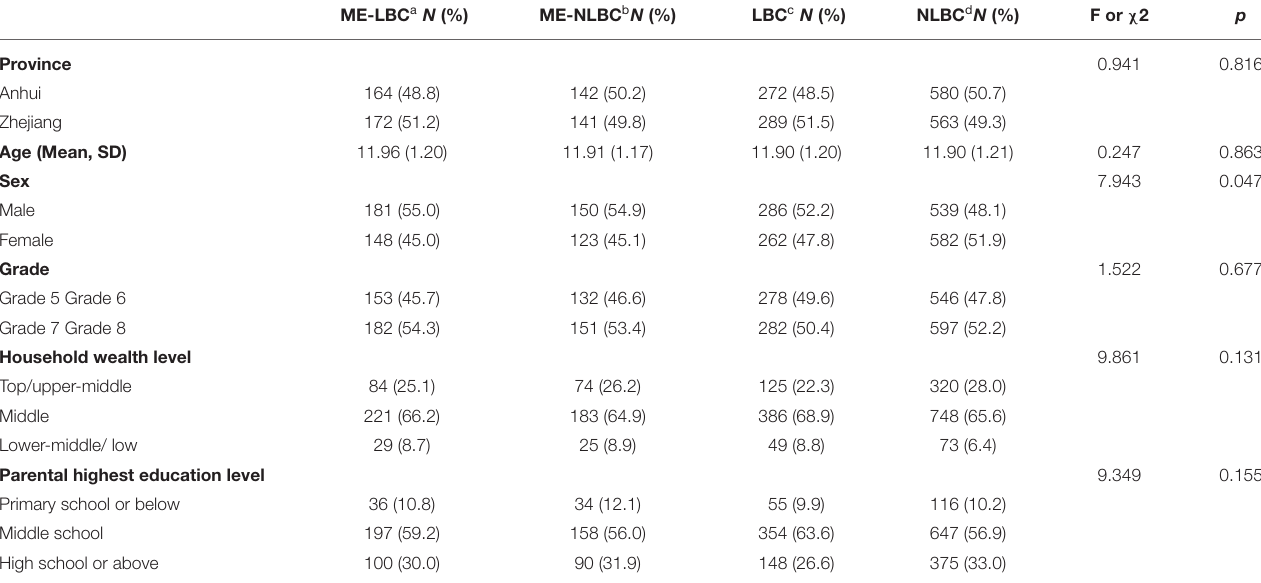
TABLE 1 | Socio-demographic characteristics of children stratified by groups.